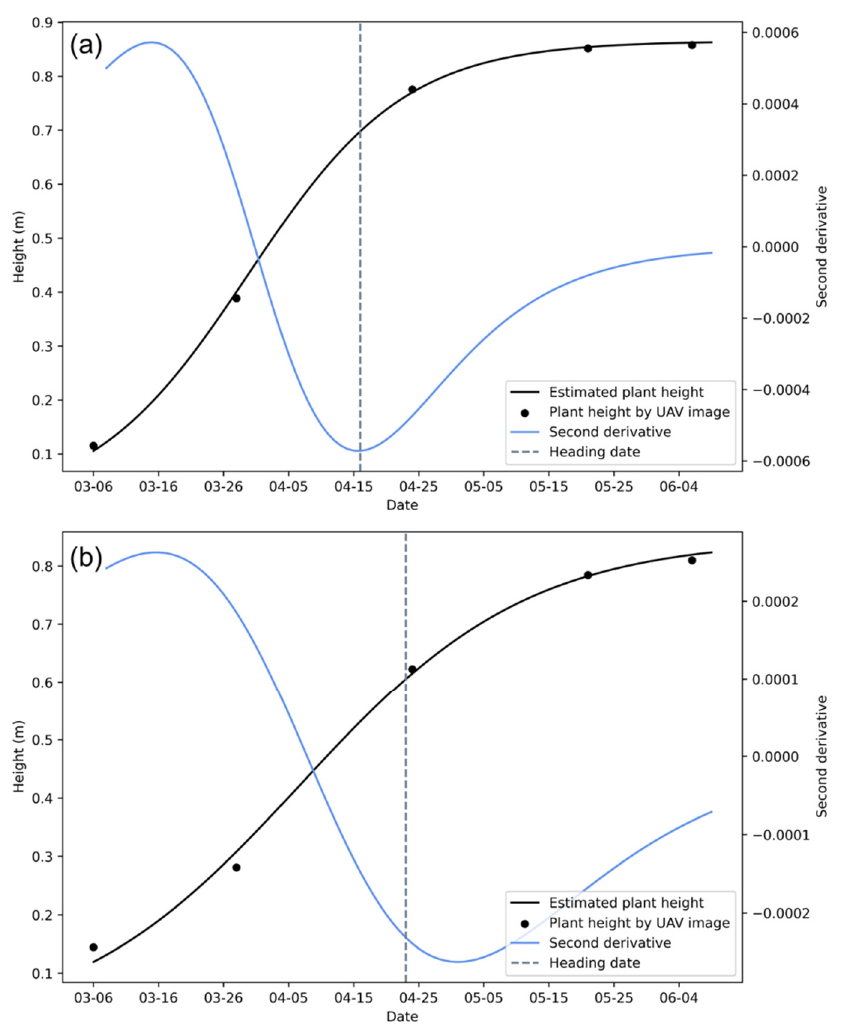
Figure 5. Figure showing plant height growth curve and the second derivative of the minimum error and maximum error plots derived using the whole region calculation method. ( a ) the minimum error plot (sowing date: 20 October; variety: Xinong 529; density: 1.5 million plants/ha), ( b ) the maximum error plot (sowing date: November 5; variety: Zhoumai 18; density: 7.5 million plants/ha). The black dots represent plant height obtained using UAV images, the black curve represents the plant height growth curve, and the gray dashed line represents the observed heading date.